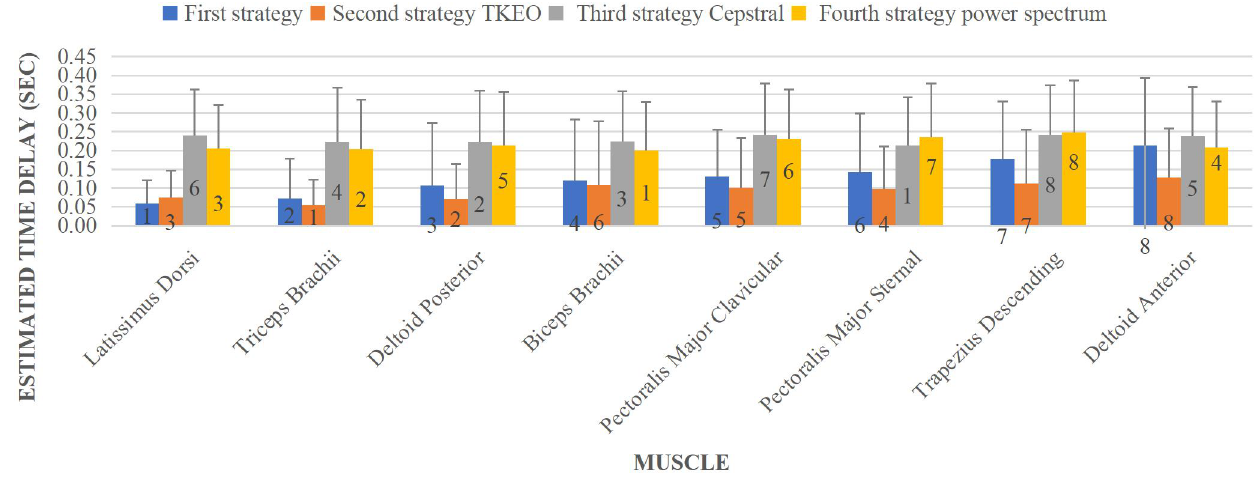
Figure 5. Estimated muscle onset based on different strategies.